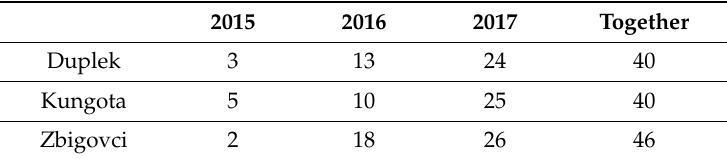
Table 1. A total number of analysis-ready images in the growing season (March–September) for each study area over the selected